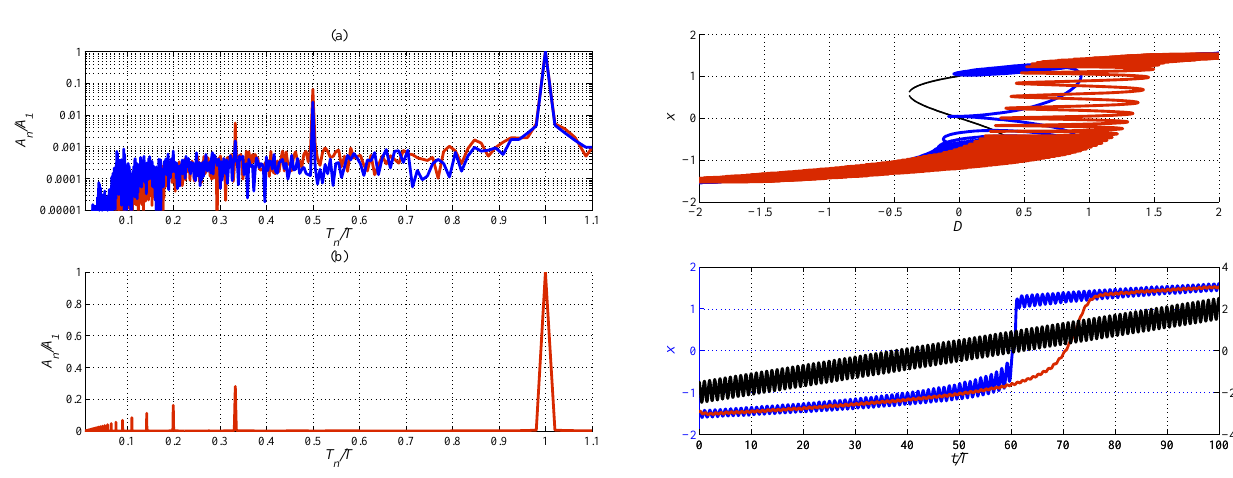
Figure 4. Ratio of the n th order harmonic amplitude to the fun- damental harmonic amplitude A n /A 1 against the ratio of the n th harmonic period to the fundamental harmonic period T n /T . The dynamics of the system are described by equation 11. In the up- per panel parameters are fixed to D a = 1 / 2, T = π (the same or- der as the system timescale τ ). The blue line is for D m = − 2 (far away from the bifurcation), the nonlinear response is dominated by the second harmonic at T n /T = 1 / 2 although small, about two orders of magnitude less than the linear response. The red line is D m = 1 / 4, close to the bifurcation the system response has be- come more nonlinear. The second harmonic ( T n /T = 1 / 2) is now almost 1 order of magnitude less and the third order harmonic ( T n /T = 1 / 3) is also prominent. In the bottom panel, we show the spectrum when the dynamics are very nonlinear. Parameters are set to D m = 0, D a = 1 / 2, T = 100 π so ωτ ≈ 1 / 100. This is the slow forcing limit shown in Fig. 1 (red line) which has a very nonlin- ear relaxation oscillation type response. Note only odd harmonics ( T n /T = 1 / 3 , 1 / 5 , 1 / 7 ,... etc.) are present due to the system expe- riencing a symmetric potential requiring the solution, x ( t ), to also have this symmetry.